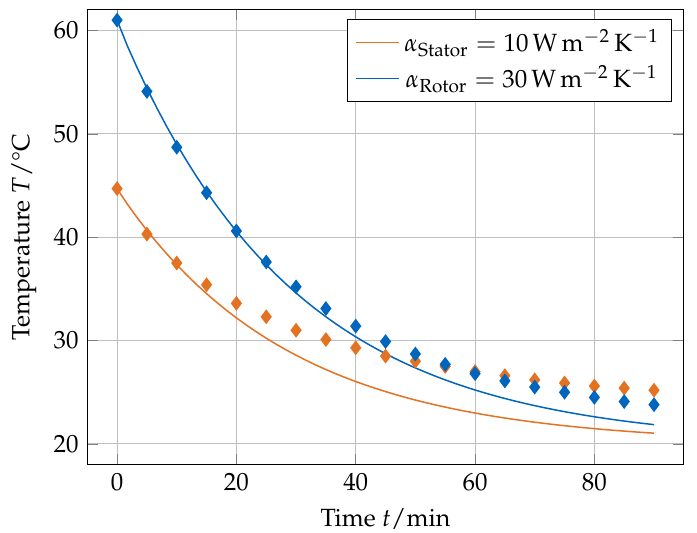
Figure 10. Calibration of heat transfer coefficients using the measured temperature decays.